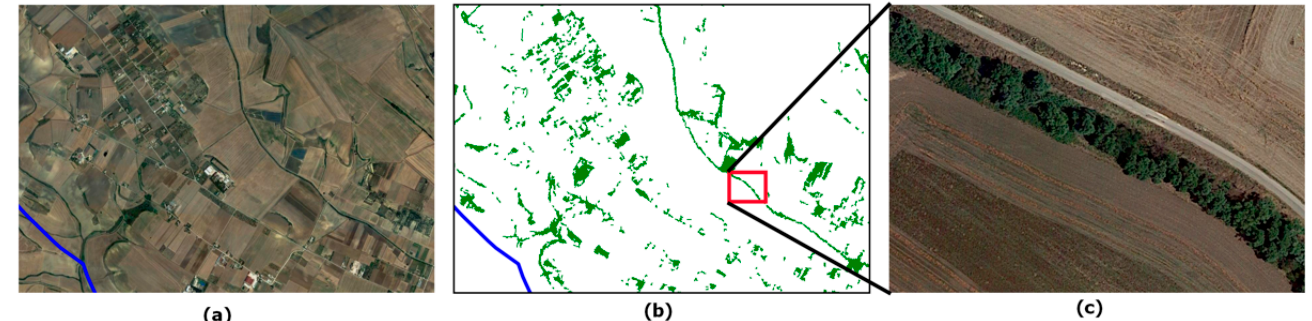
Figure 14. Overestimation and misclassification in the Copernicus grasslands layer 2018. ( a ) Aerial photo (2018); ( b ) Copernicus grasslands layer; ( c ) aerial photo close-up in which dense tree canopies result rather than grasslands along the